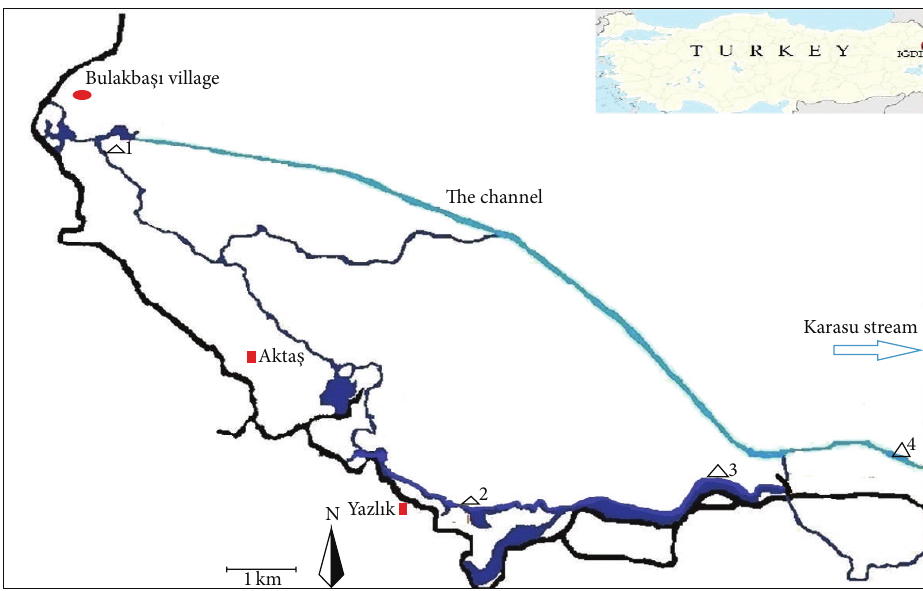
Figure 1: Bulakbas¸ı stream and four sampling